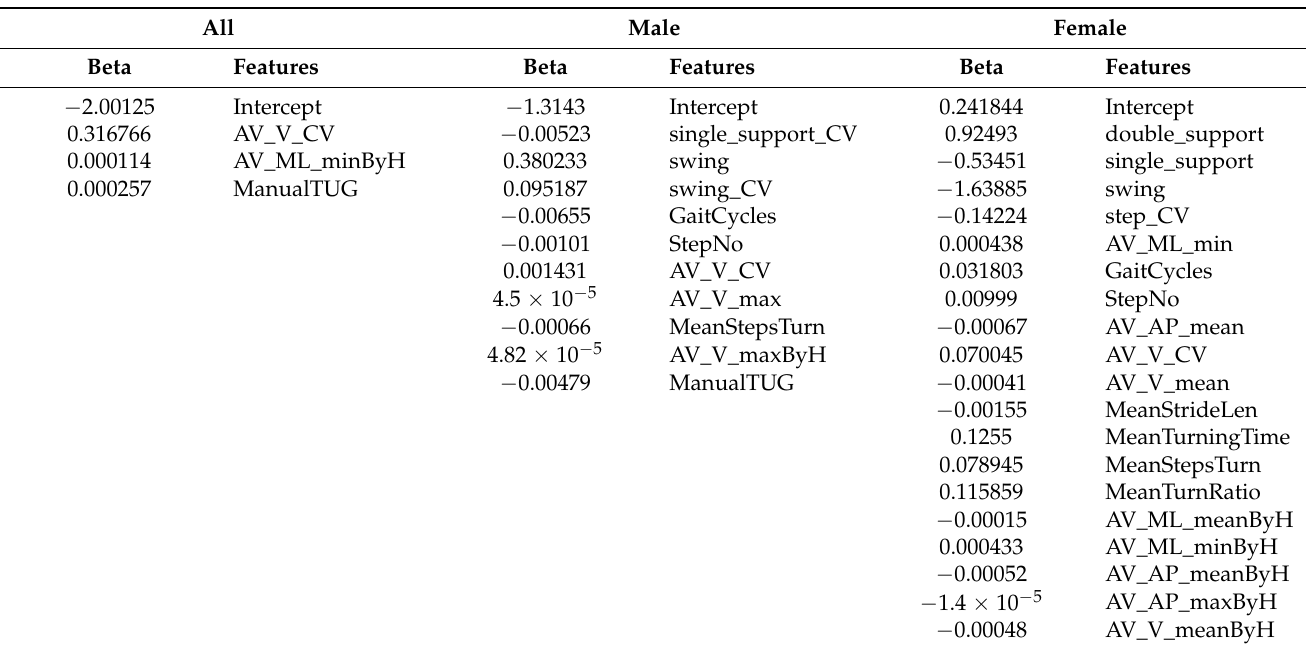
Table A9. TD-Fallers-PD falls count model coefficients. Beta refers to Poisson regression coefficients, chosen through an elastic net procedure.